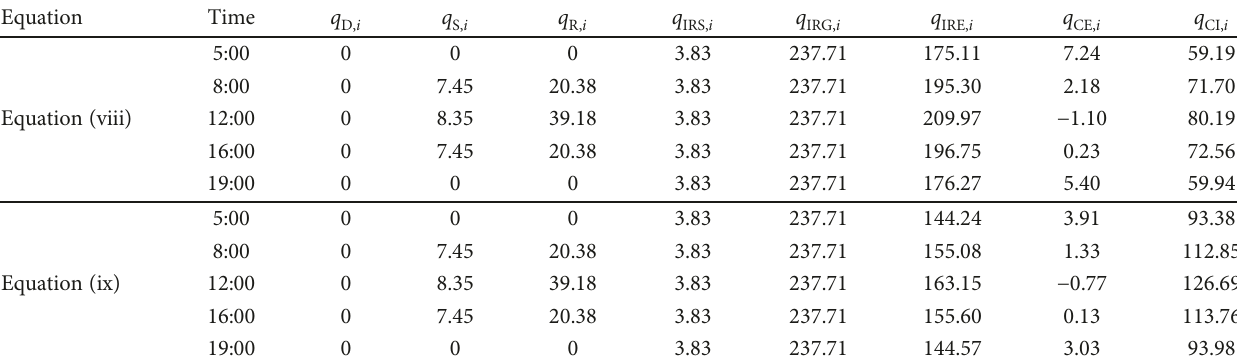
Table 4: Heat fl ux of the lower envelope calculated by di ff erent forced convection